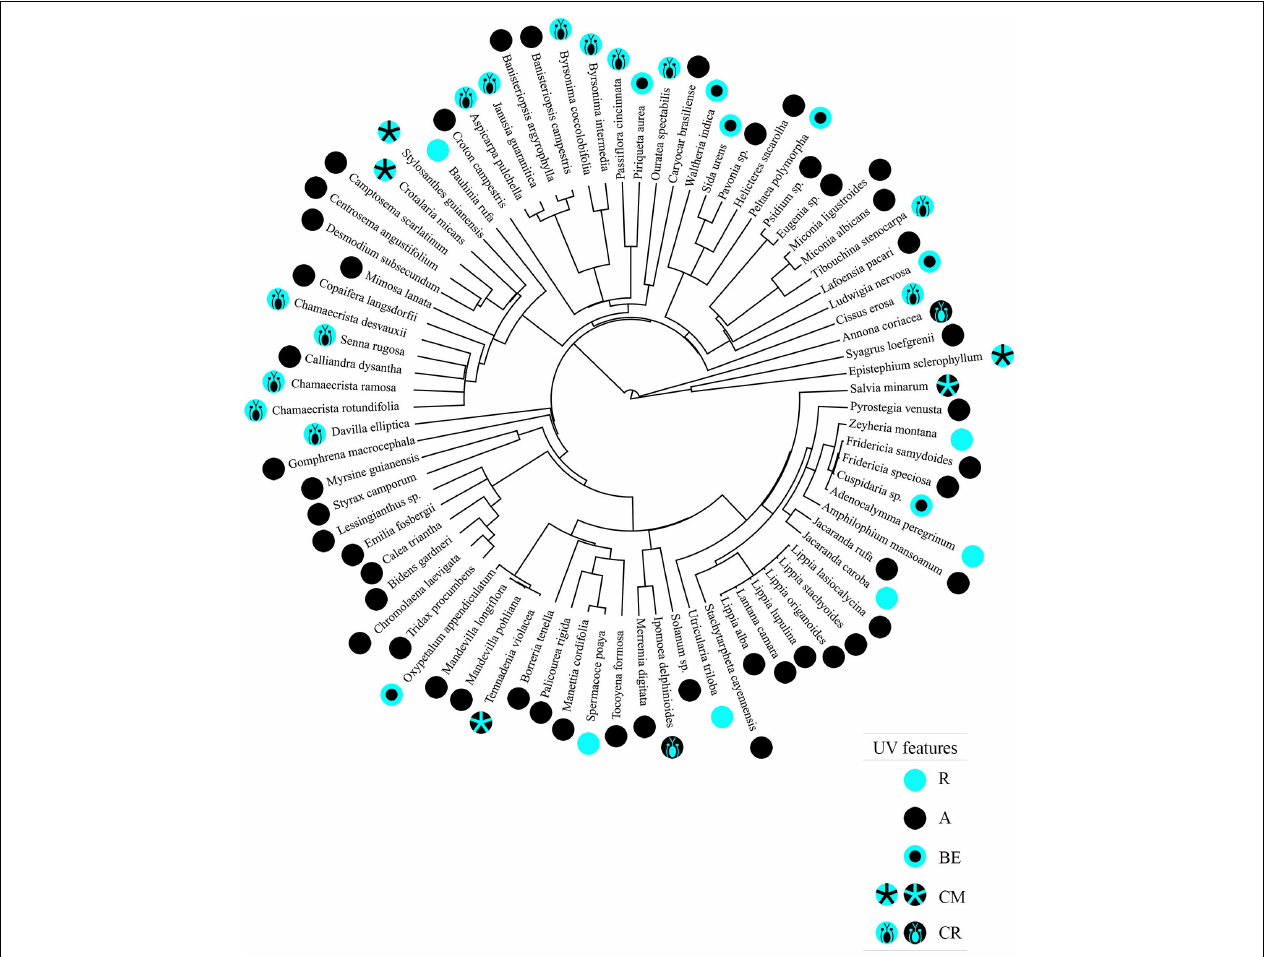
FIGURE 7 | Phylogenetic tree representing 80 Neotropical savanna plant species based on the megaphylogeny by Qian and Jin (2016), including the floral UV features of each plant species. R, non-patterned UV-reflecting; A, non-patterned UV-absorbing; BE, bullseye; CM, contrasting corolla markings oriented toward floral resources; CR, contrasting reproductive structures. The types of floral UV features are represented by symbols in which blue represents UV-reflection and black represents UV-absorption. Pleroma stenocarpa and Betencoutia scarlatina are represented in the figure by their synonyms Tibouchina stenocapa and Camptosema scarlatinum , respectively, because the updated nomenclature was not compatible with the species name in the